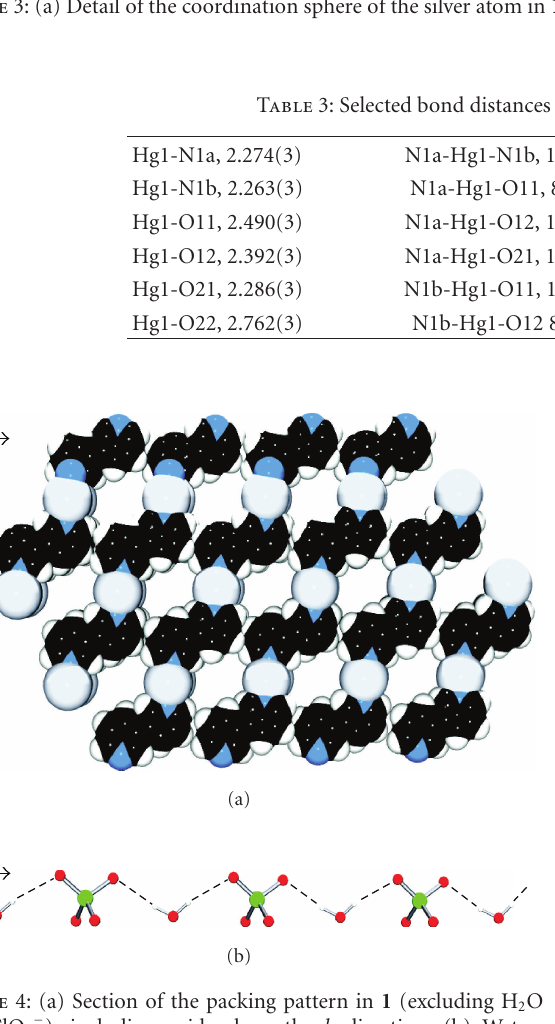
Figure 3: (a) Detail of the coordination sphere of the silver atom in 1 . (b) Polymeric motif between Ag1 and 3,3 (cid:2) -bpy bridging ligands in 1 .